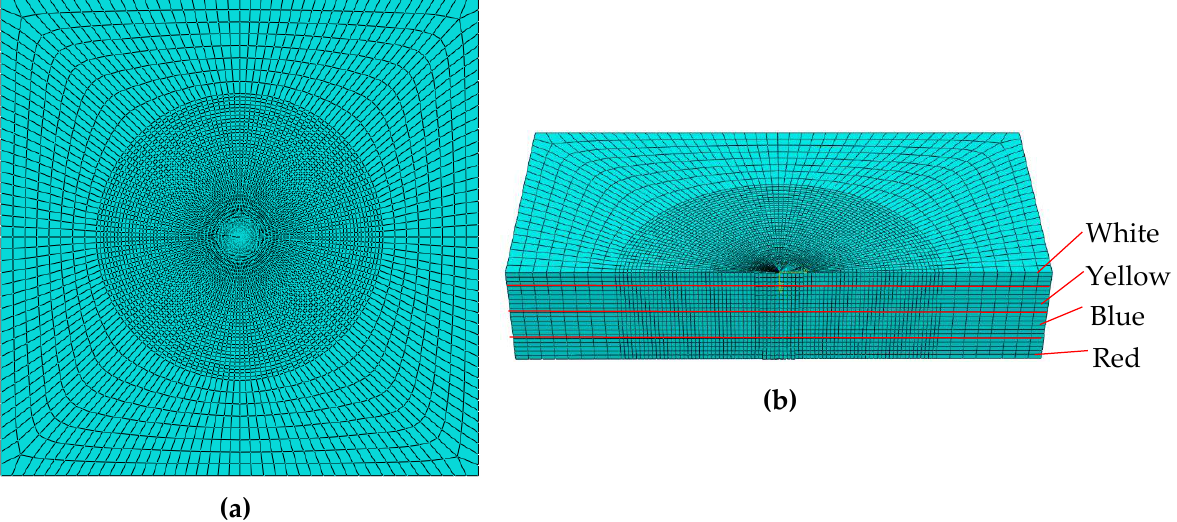
Figure 24. ( a ) Mesh distribution. ( b ) Isometric half view of denser mesh.